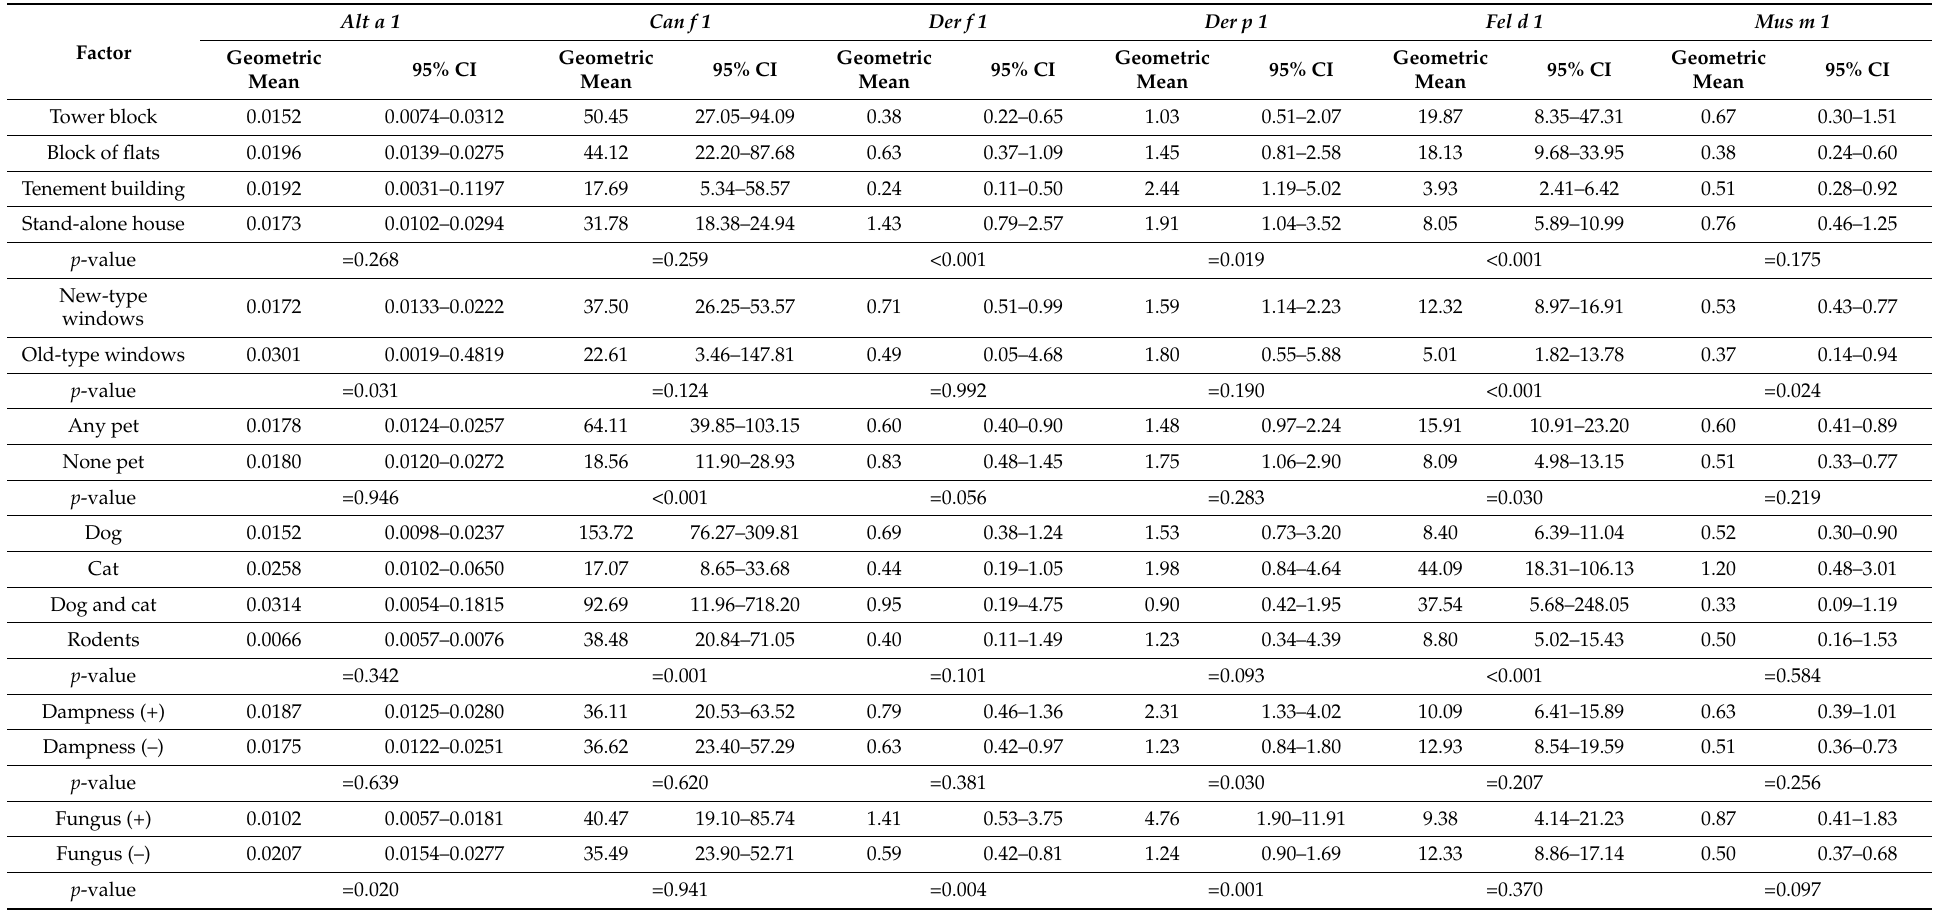
Table 3. Descriptive statistics for the concentrations of allergens in dust (ng/mL) in the studied children by selected environmental